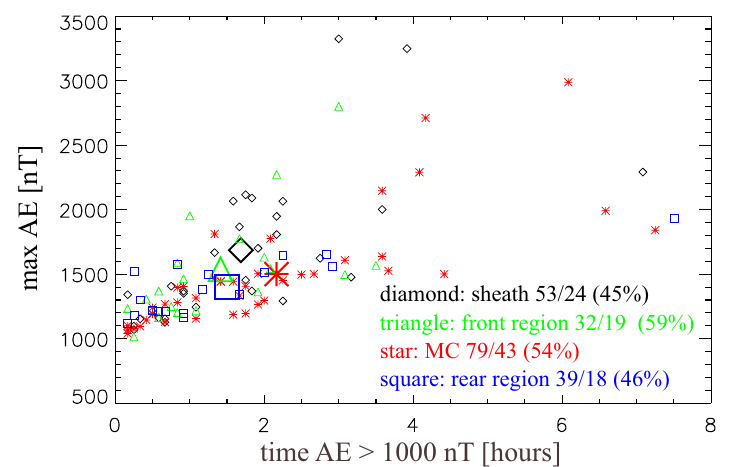
Fig. 34 High-latitude response to sheaths (black diamonds), MCs (red stars), and the MC front (green triangles) and rear regions (blue squares). The data set consist of the same 79 events from 1996 to 2009 as analyzed in Kilpua et al. (2013b). The plot shows the maximum AE as a function of total time when AE > 1000 nT within each region. The large symbols show the averages for each region. The first number gives the total number of each region (note that not all MCs have sheaths, front or rear regions) and the second number the cases that had significant high-latitude response (AE > 1000 nT) (percentage also shown in